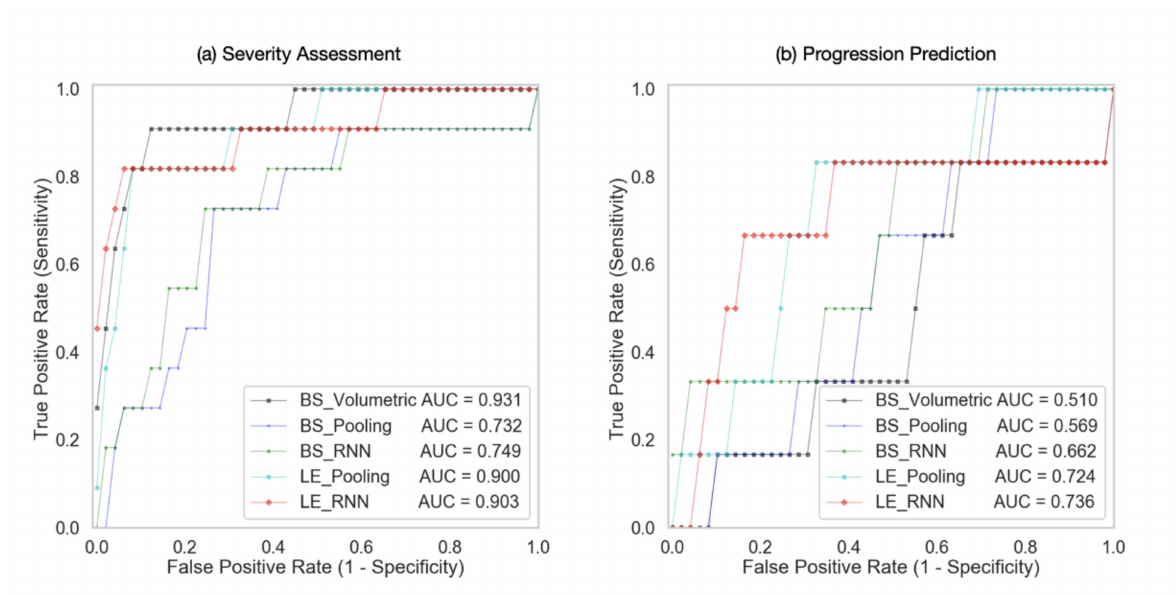
Figure 5. ROC curves of different models in ( a , b ) .